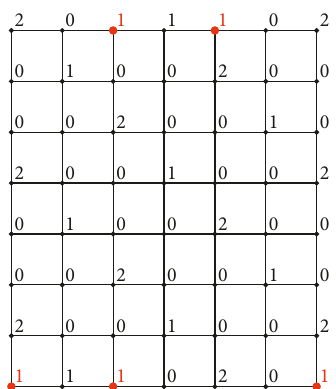
Figure 8: The function f ′ where r � 3 k + 1 , s � 3 l + 2 and r ≡ 1 mod6 ,